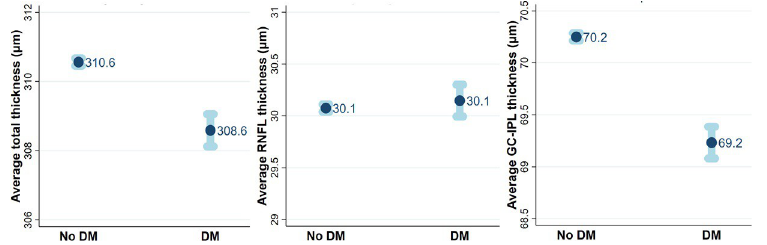
Fig 1. Difference in retinal thickness measurements between participants with and without diabetes. Fig 1 shows the difference in average thickness measurements (95% confidence interval) between participants with and without diabetes (DM) after adjusting for co-variates: a) total retinal thickness, b) retinal nerve fiber layer (RNFL) thickness, c) ganglion cell inner plexiform layer (GC-IPL) thickness.